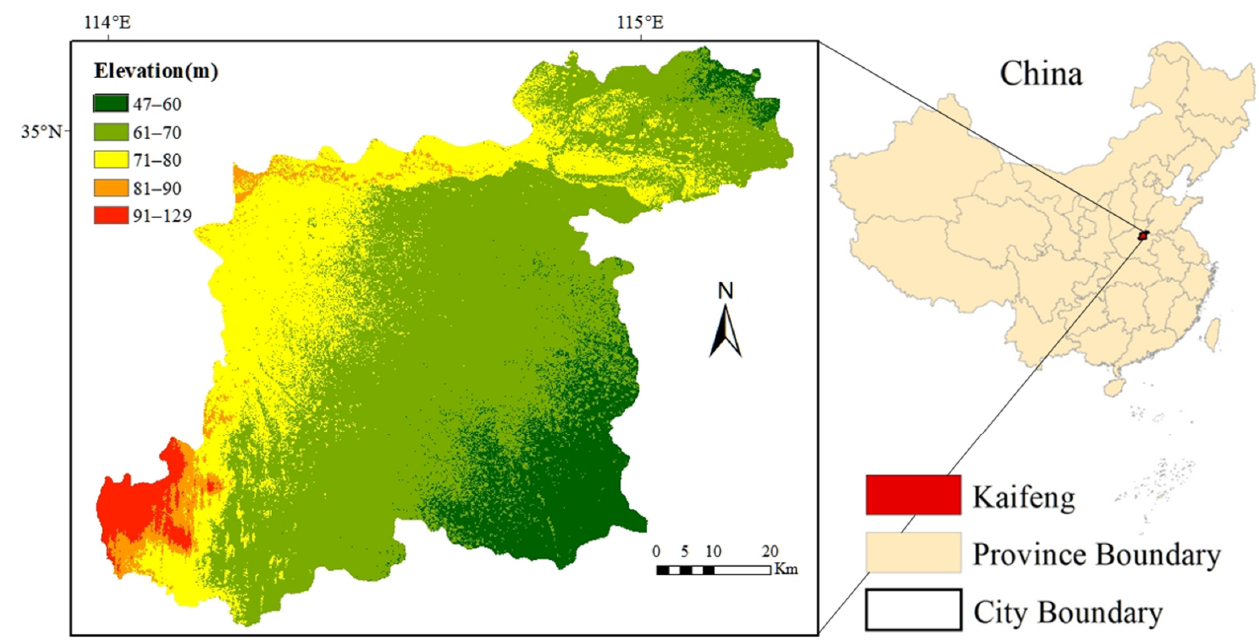
Figure 3. Topographic location of Kaifeng, Henan Province, China. Table 1. Basic characteristics of sample